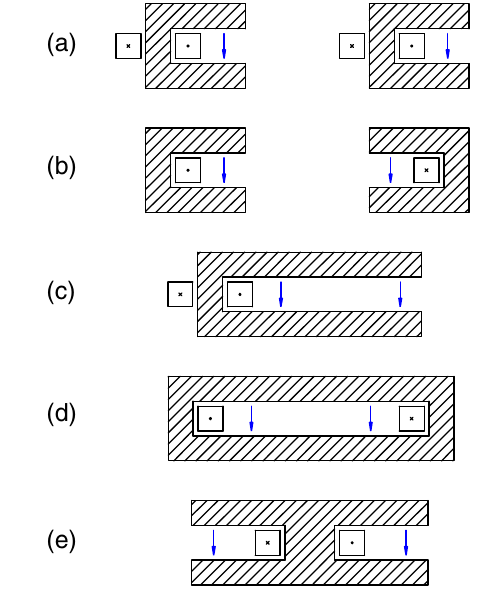
FIG. 5. Schematic layouts of twin dipoles